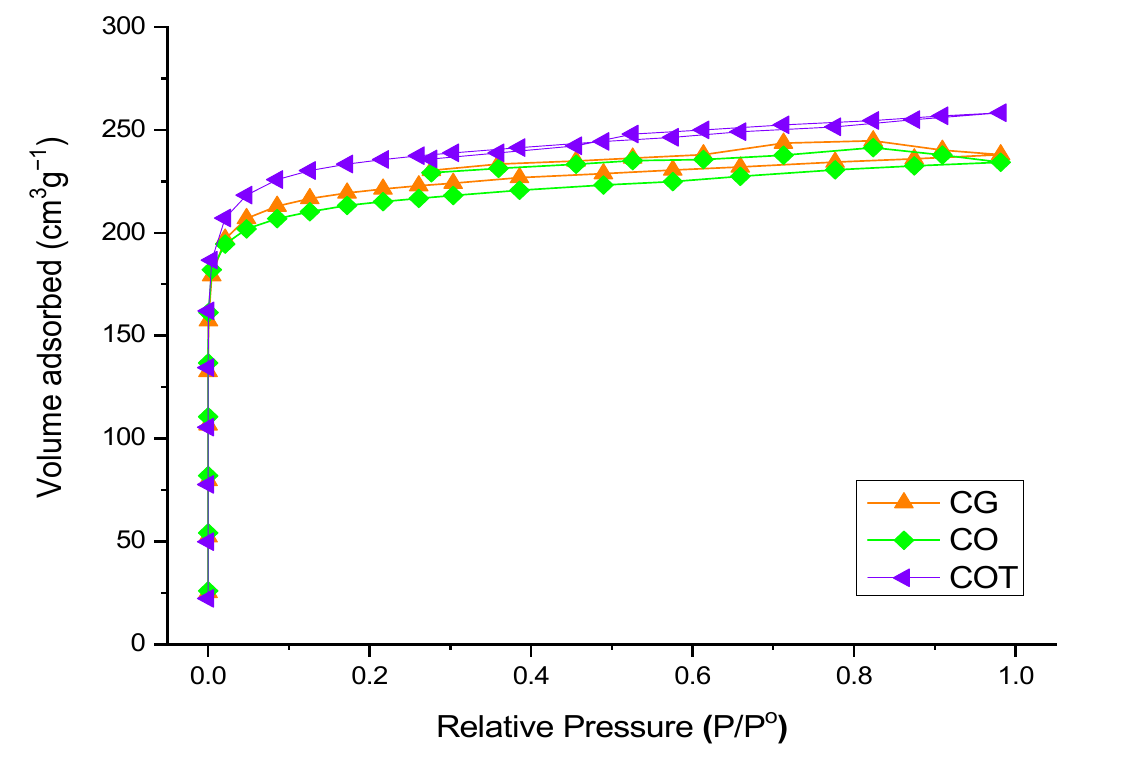
Figure 1. N 2 adsorption isotherms at 77 K of the activated carbons. Table 1. Textural and chemical parameters of the activated carbons.